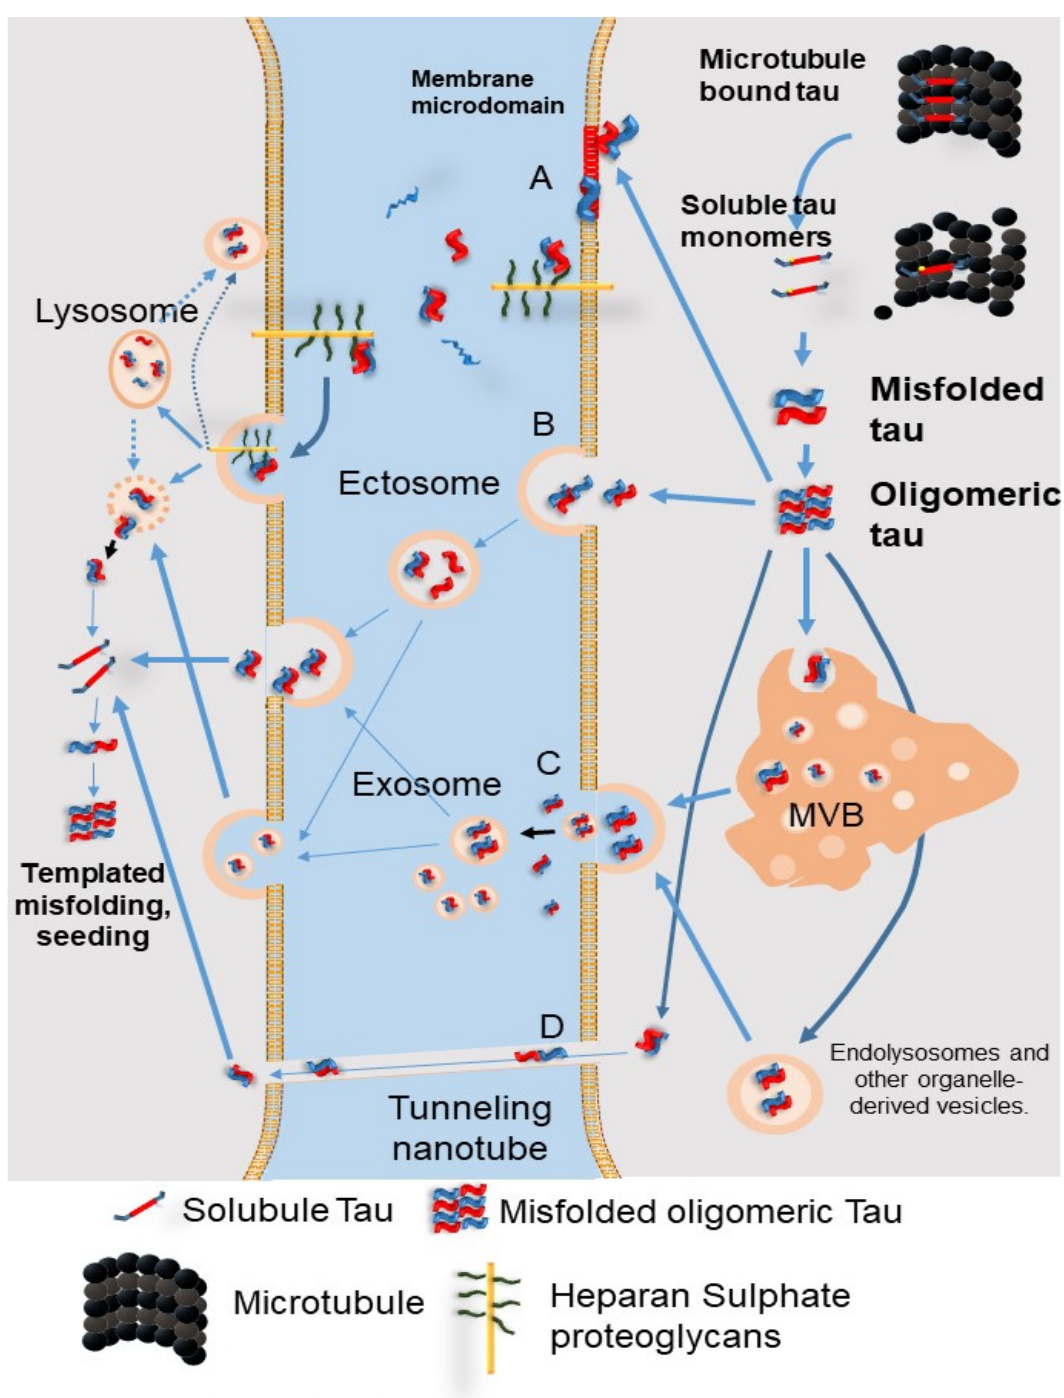
Figure 6. The secretion pathways of pathological tau protein. ( A ) Direct secretion of tau through the plasma membrane involves clustering of tau at the plasma membrane, interaction of cholesterol/sphingomyelin-rich membrane microdomains with specific lipids, permeation into the plasma membrane, and release from the plasma membrane by cell surface heparin sulfate proteoglycans. ( B ) Tau is secreted into ectosomes, which are larger and have a different composition than the exosomes released from the plasma membrane. Both ectosomes and exosomes function in the same manner after they are released from the cell, fusing to the target cell or being endocytosed. ( C ) Secretion of tau by exosomes and organelle hitchhiking. Tau may be secreted when the membrane of late endosomes exits inward to form luminal vesicles of the multivesicular body (MVB), which are packed into exosomes, and when the MVB membrane fuses with the plasma mem- brane. Organelle hitchhiking pathways that may be involved in the secretion of tau and other misfolded cytoplasmic